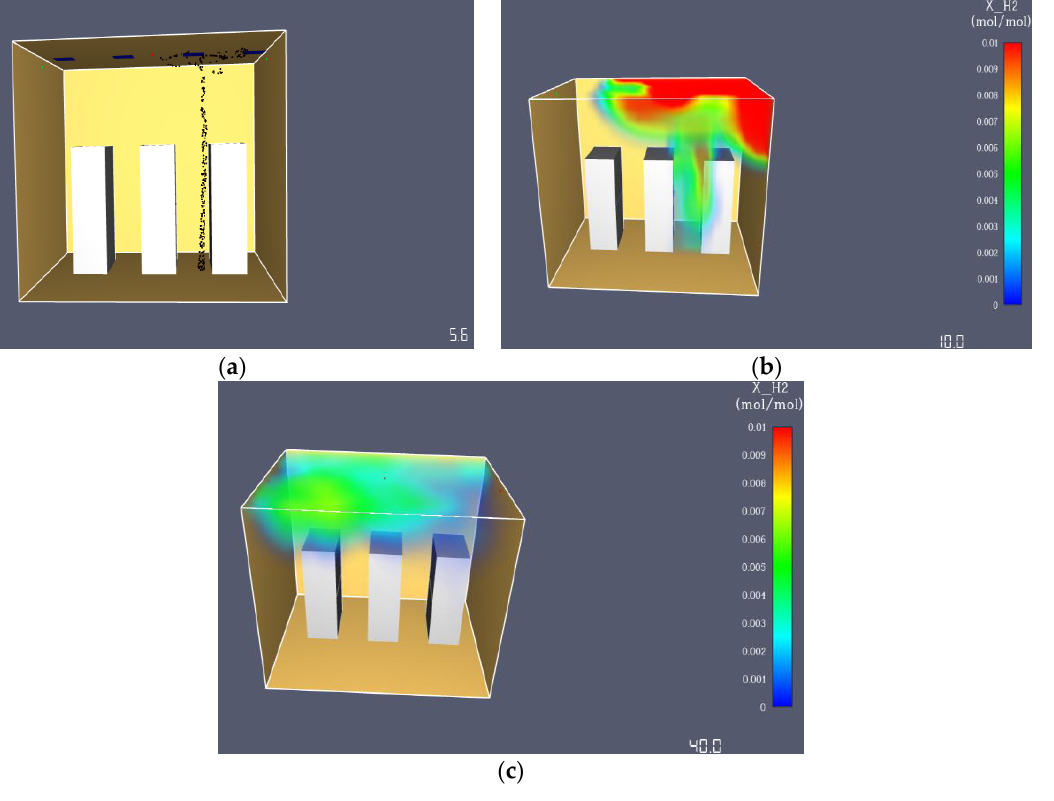
Figure 9. Leakage diameter 3 mm at the inlet of the bottom right stack: ( a ) detection at 5.6 s; ( b ) concentrations at 10 s; ( c ) concentrations at 40 s. ( b ) concentrations at 10 s; ( c ) concentrations at 40